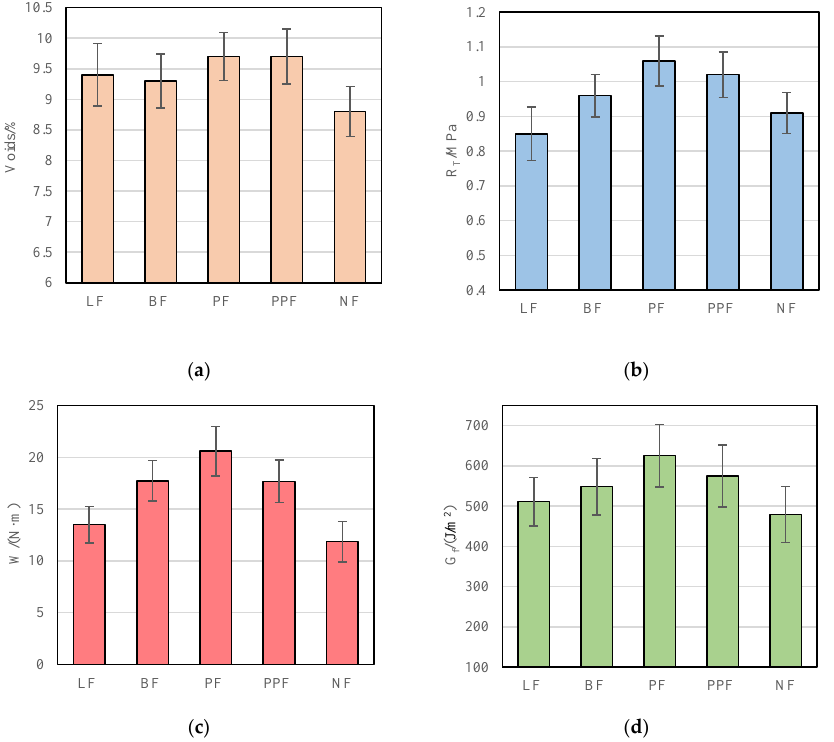
Figure 7. Low-temperature performance of CRM under different fiber types. ( a ) Voids; ( b ) R T ; ( c ) W; ( d ) G f . It can be seen from Figure 7 that among polyester fiber, basalt fiber, lignin fiber, and polypropylene fiber, CRM with polyester fiber has the largest dry splitting strength (R T ), fracture work and fracture energy. Compared with CRM without fiber, the dry splitting strength (R T ), fracture work, and fracture energy are increased by at least 16%, 73%, and 30%. In previous studies, Wang et al., Hao et al., and others also believed that polyester fiber had a more obvious effect on improving the low-temperature performance of CRM [40,41]. Therefore, polyester fiber is recommended to be used. Subsequently, the optimal content of polyester fiber was optimized. (2) Optimization of fiber content The test results of voids, dry splitting strength (R T ), fracture work, and fracture en- ergy of CRM under different fiber contents are shown in Figure 8.